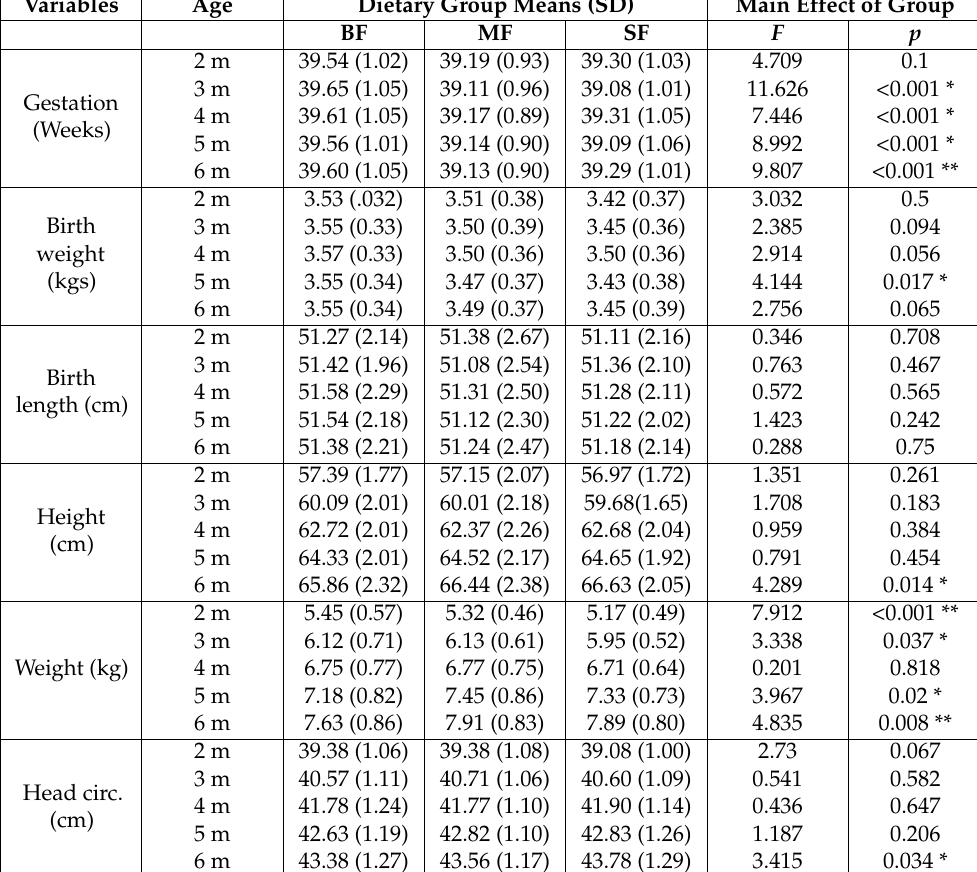
Table 2. Anthropometric Measures by Age and Dietary